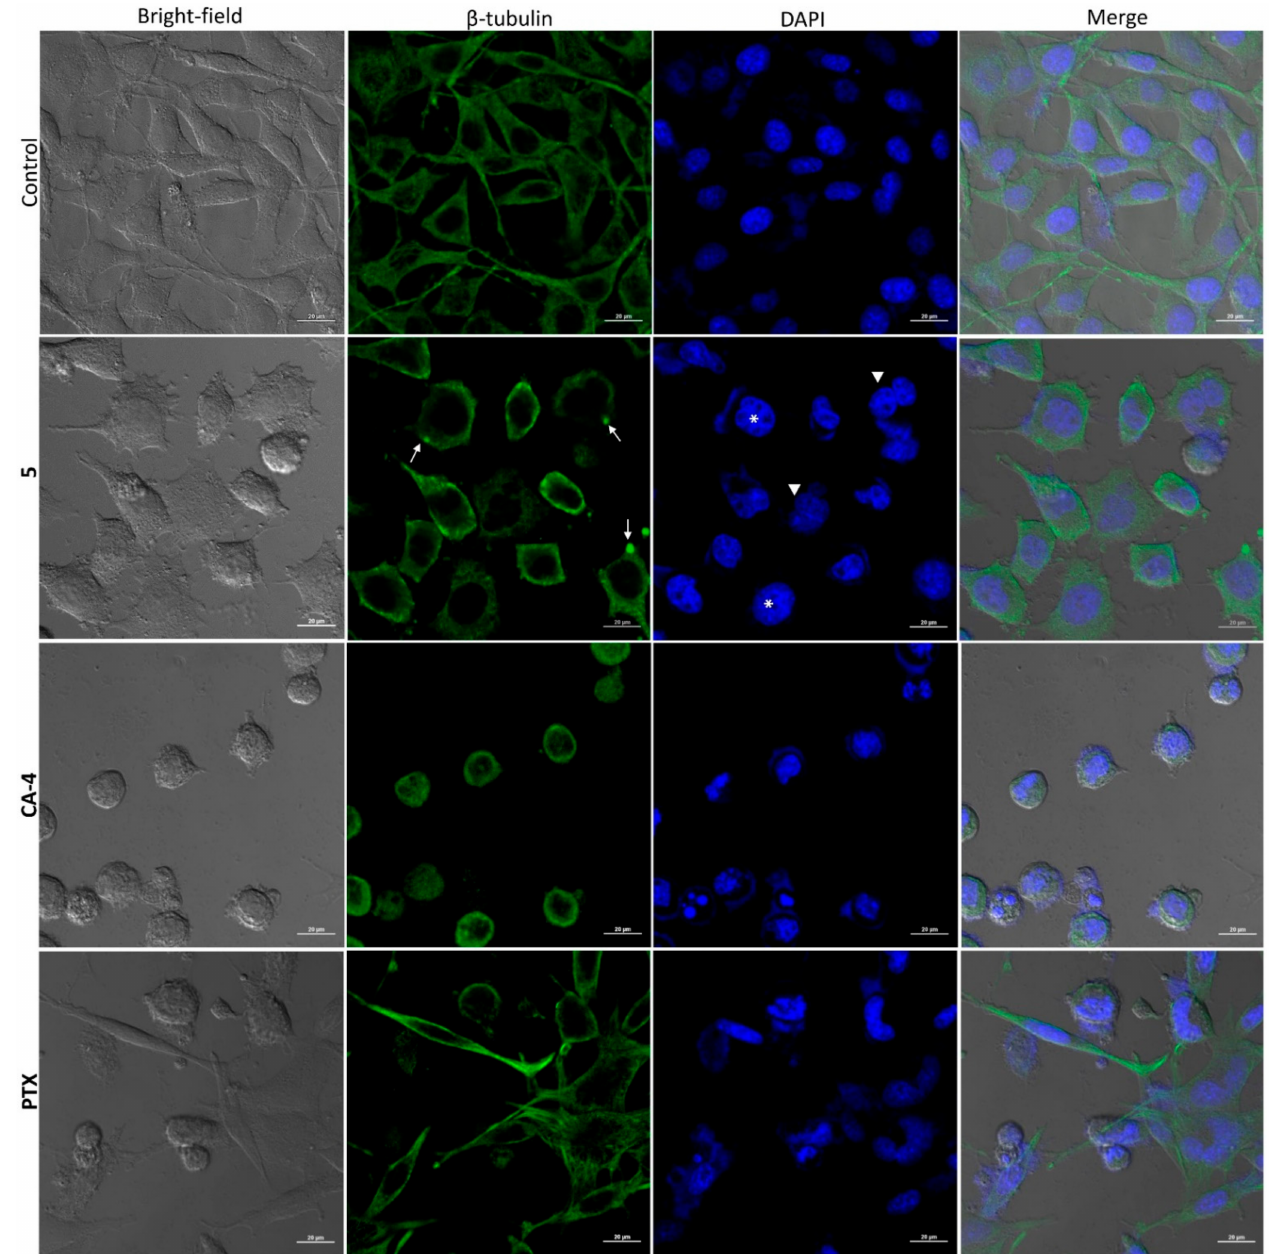
Figure 4. Effect of compound 5 , PTX , and CA-4 on HeLa cells tubulin network analyzed by indirect immunofluorescence. Cells were treated with DMSO at 0.01% (Control), compound 5 (0.16 µ M), CA-4 (1.49 µ M) and PTX (0.08 µ M) for 24 h. Cell samples were incubated with anti-beta-tubulin antibody at 1:1000 dilution and anti-mouse IgG-FITC diluted 1:1000 as secondary antibody. The nuclear DNA was stained with 4,6-diamidino-2-phenylindole (DAPI). Beta-tubulin is stained in green, DNA in blue. First column: Bright-field images, second column: Beta-tubulin array, stained with FITC, third column: DAPI stain, fourth column: Merge. Samples were visualized by confocal microscopy. Arrow: Tubulin aggregates; Arrowhead: Multinucleation; Asterisk: Macronuclei. Scale bar: 20 µ